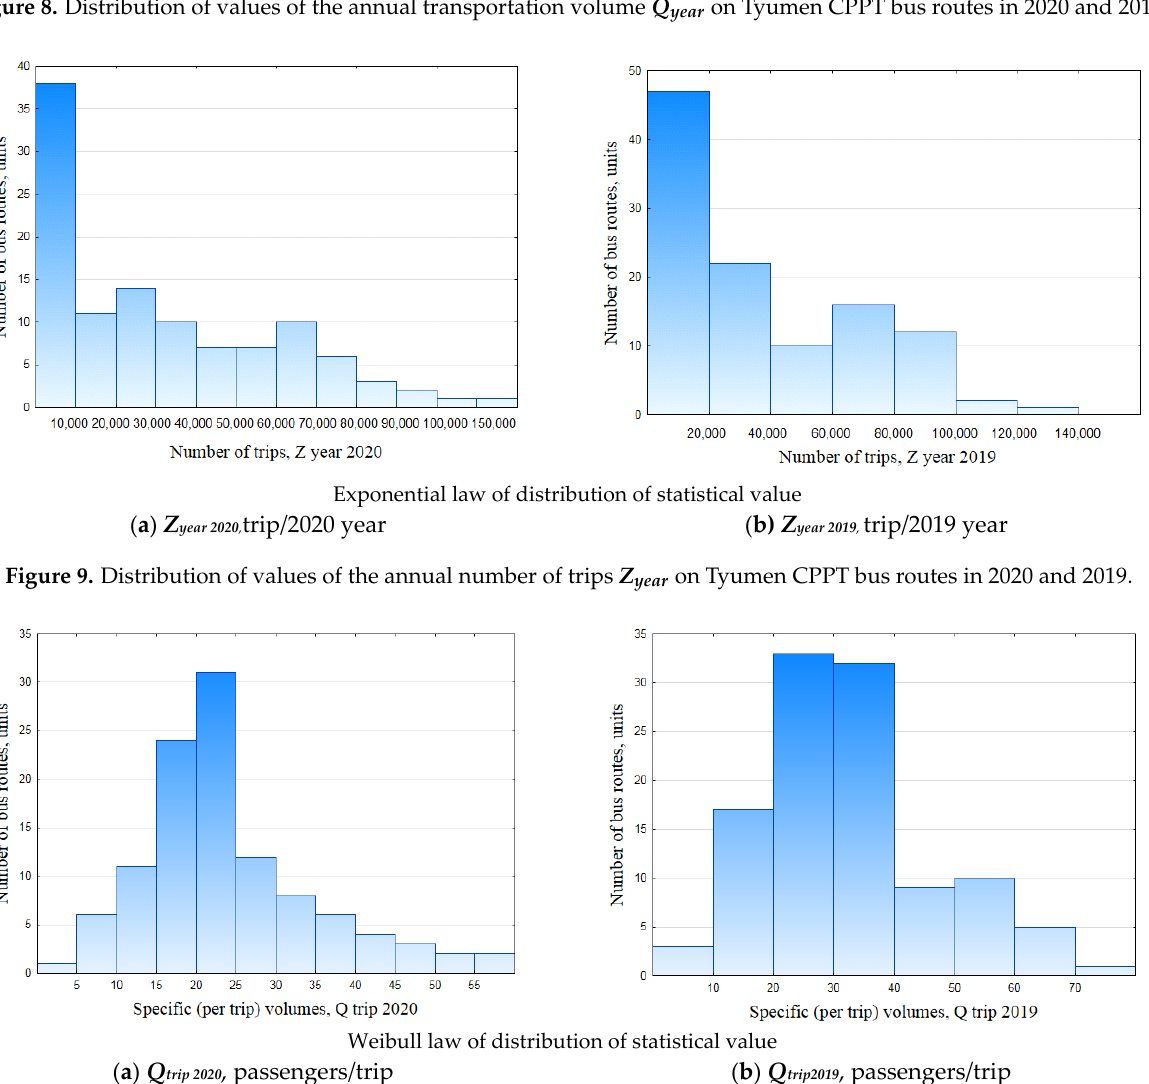
Figure 8. Distribution of values of the annual transportation volume Q year on Tyumen CPPT bus routes in 2020 and 2019.